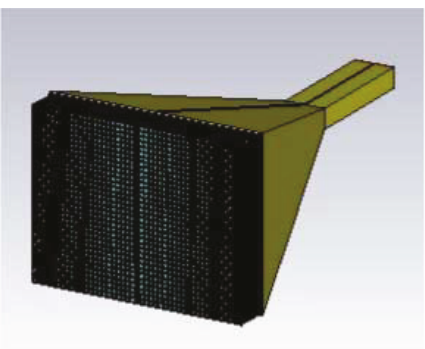
Figure 6: Gradient refractive index structure at the aperture of the pyramidal horn